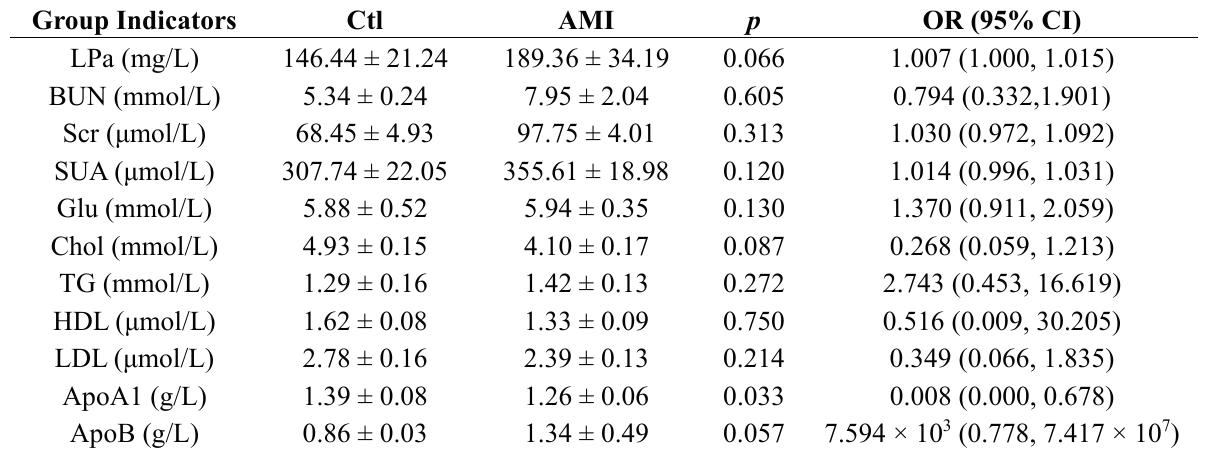
Table 2. Correlation analysis between miR-19a and the risk factors of AMI.